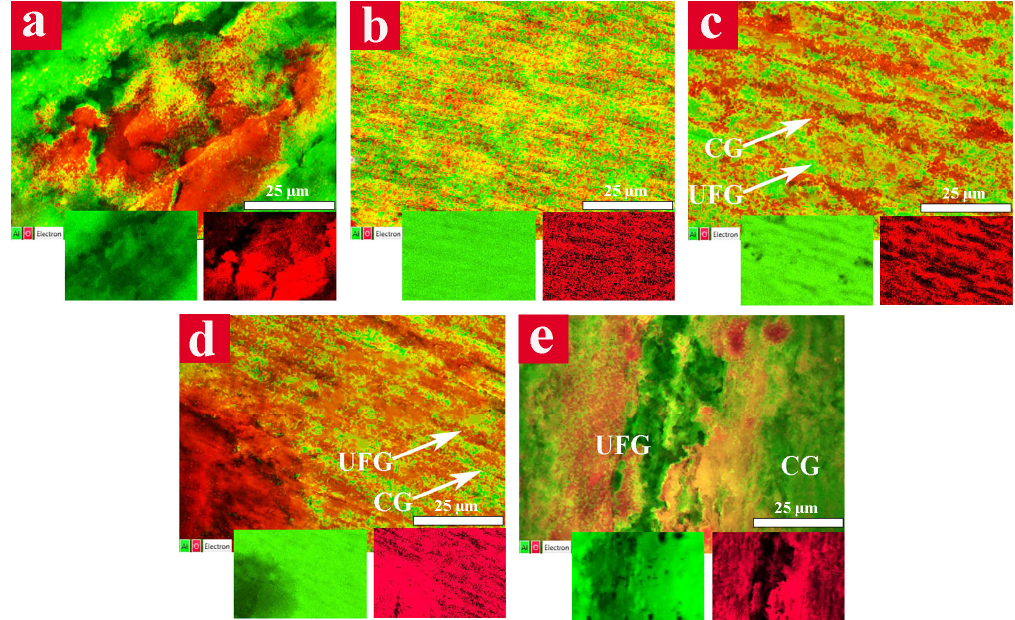
Figure 8. Energy dispersive spectroscopy (EDS) maps of Al6063 samples after corrosion tests: ( a ) CG; ( b ) UFG; ( c ) 15 vol. % CG bimodal; ( d ) 30 vol. % CG bimodal; and ( e ) 45 vol. % CG bimodal.